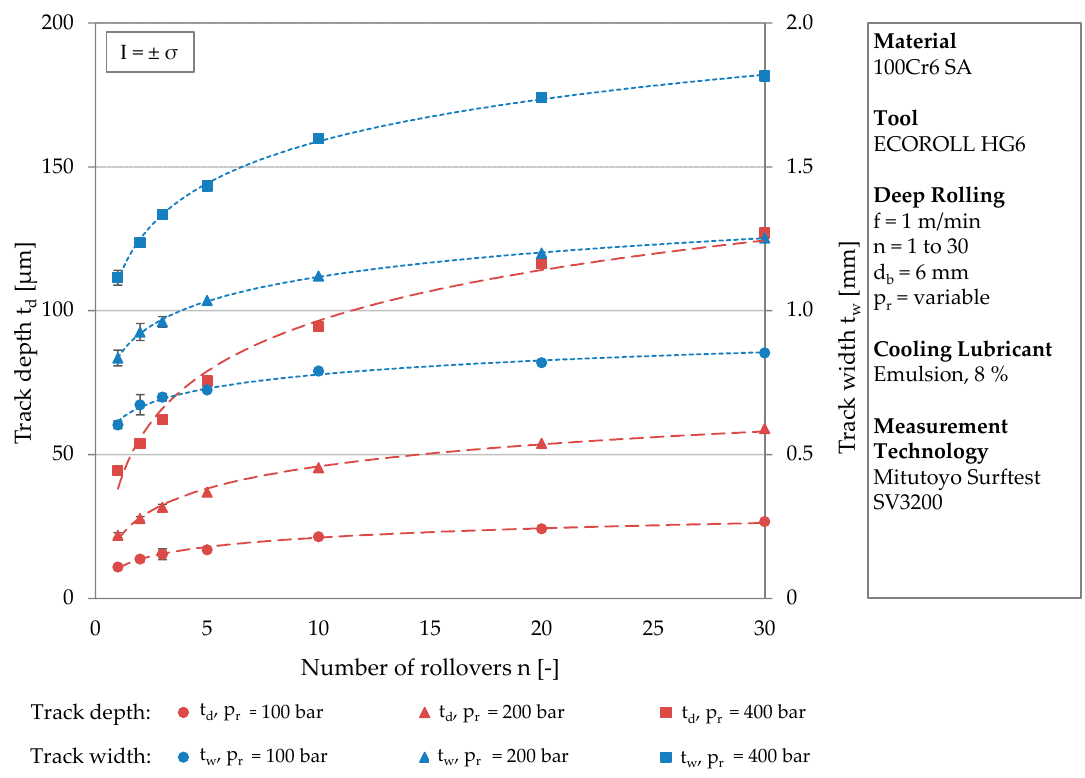
Figure 3. Development of the track depth and the track width at different deep rolling pressures with an increasing number of rollovers.